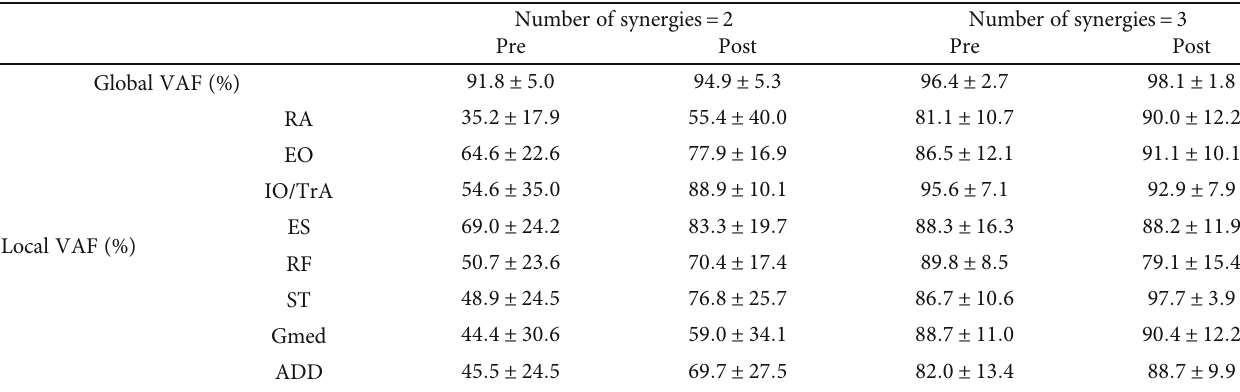
Table 1: Relationship between the number of synergies and the global and local VAF. The number of synergies is decided when the global VAF exceeds 90% and the local VAF exceeds 75% for the fi rst time.